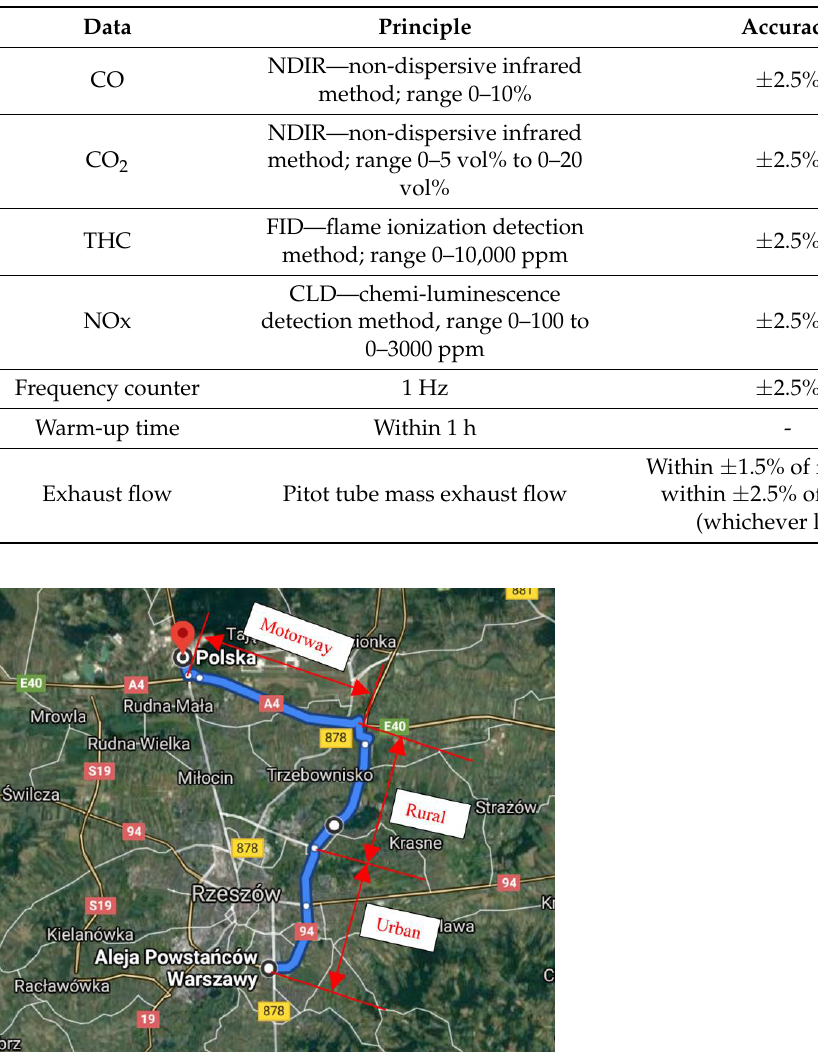
Figure 2. View of the vehicle on the test stand. Table 1. Technical data of the tested vehicle. Table 3. Selected technical parameters of the PEMS Horiba OBS-2200.